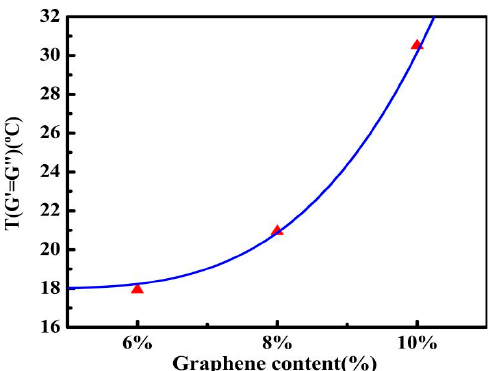
Figure 9. T G’=G’’ versus graphene content after percolation threshold, and fitted curve by an equation similar to classical percolation theory equation.